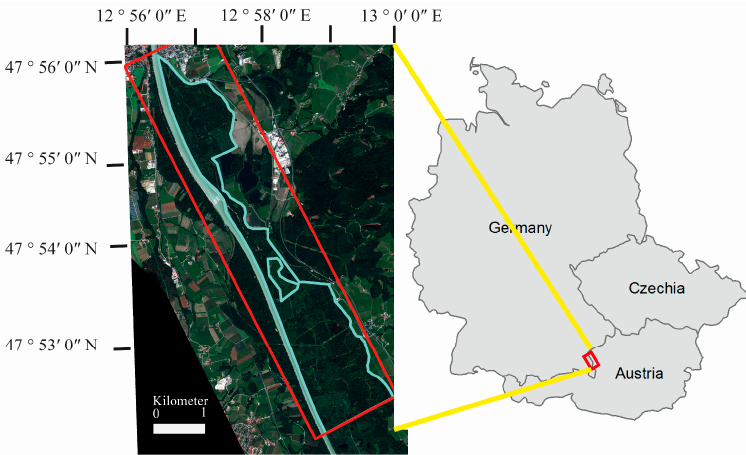
image is a very-high-resolution WorldvIew-2 image. The red box shows the coverage of the airborne prism experiment (APEX) hyperspectral imagery, and the blue polygon illustrates the area of interest which was used in this